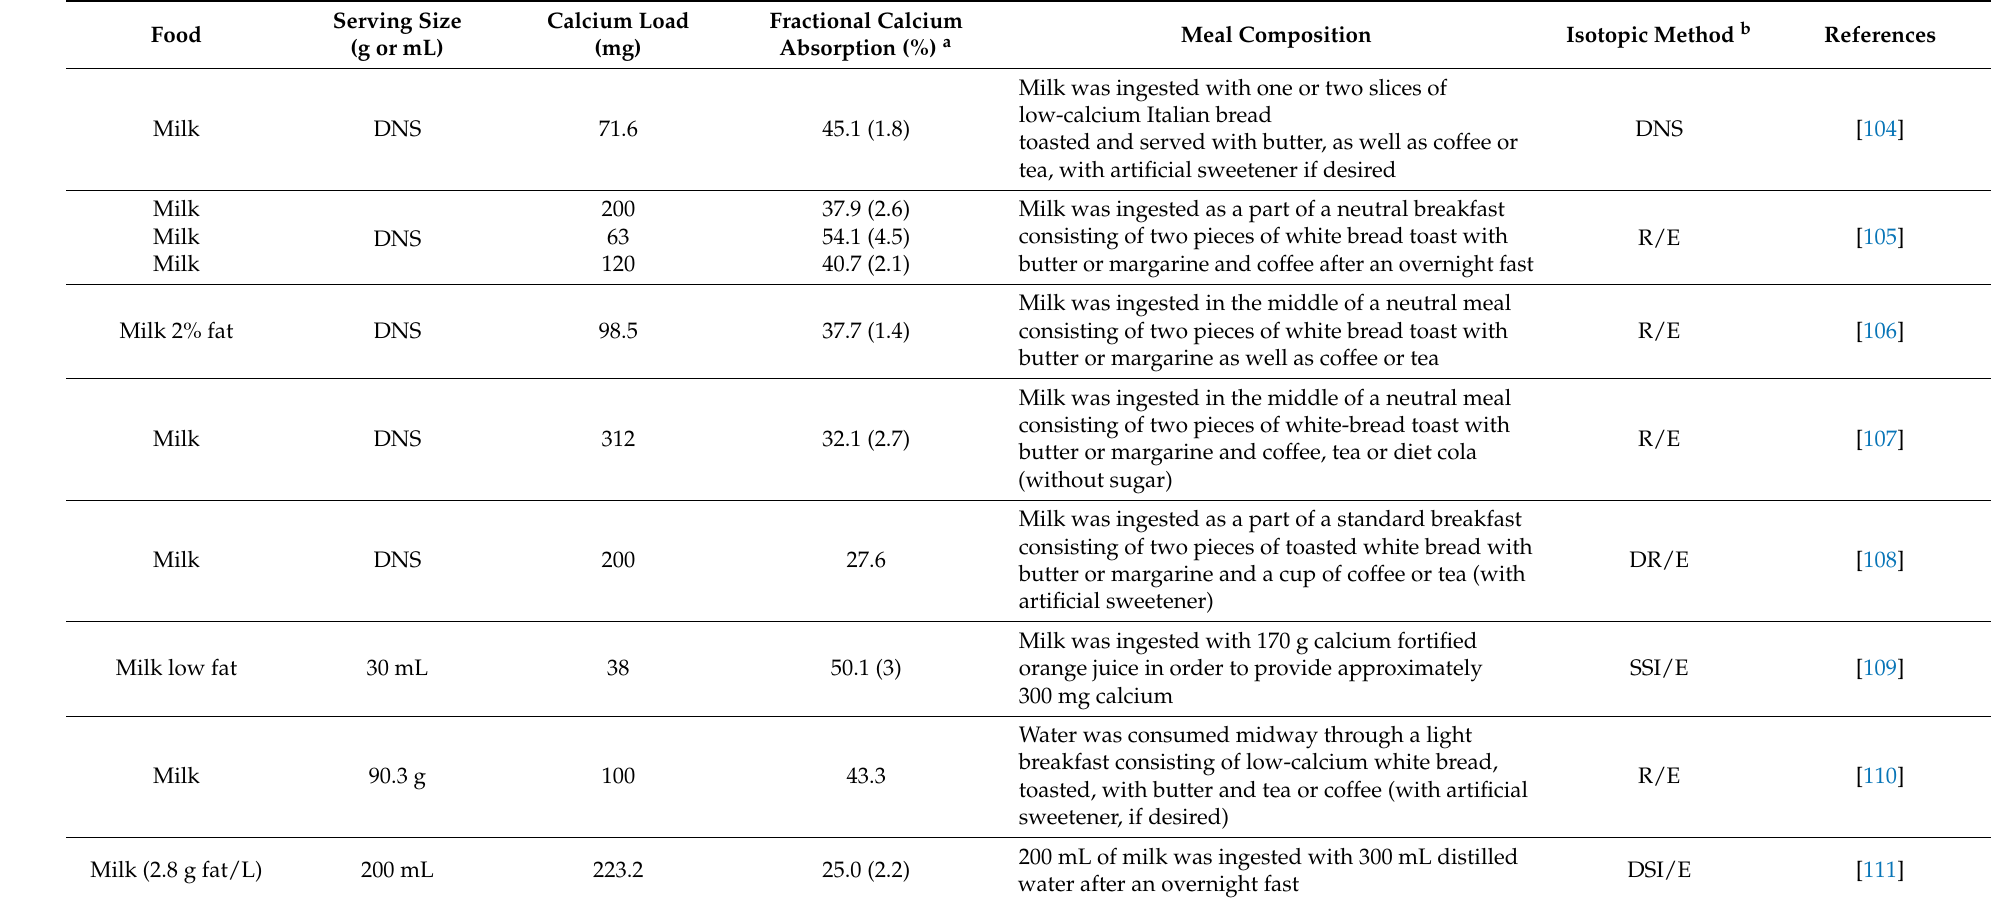
Table 4. Fractional absorption of calcium from dairy